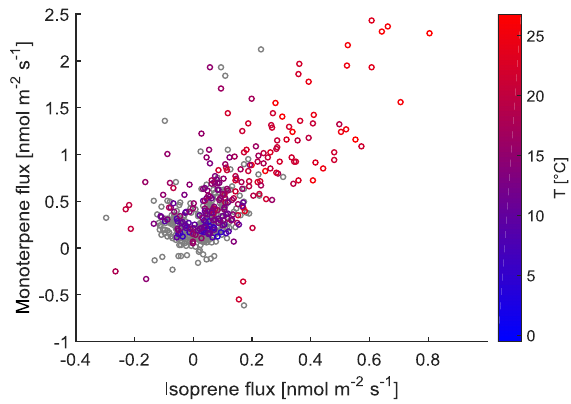
Figure 5. Scatterplot of 30min isoprene and monoterpene flux. The gray data points are values where the PAR was smaller than 200µmolm − 2 s − 1 . Isoprene fluxes are very low and especially dur- ing low PAR conditions they are heavily affected by noise and a mirroring effect (Langford et al.,